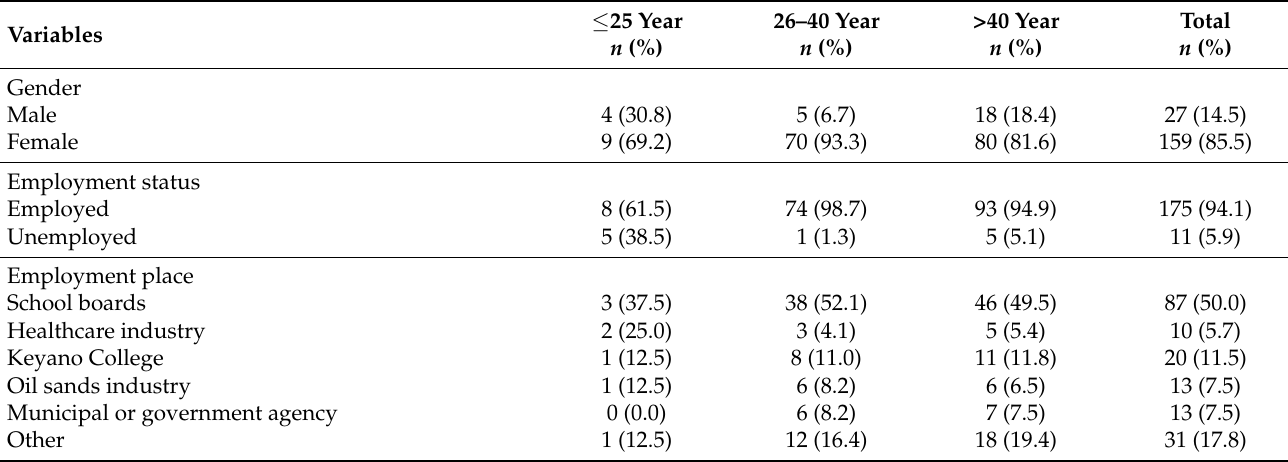
Table 1. Demographic profile, clinical characteristics, and support received by the study